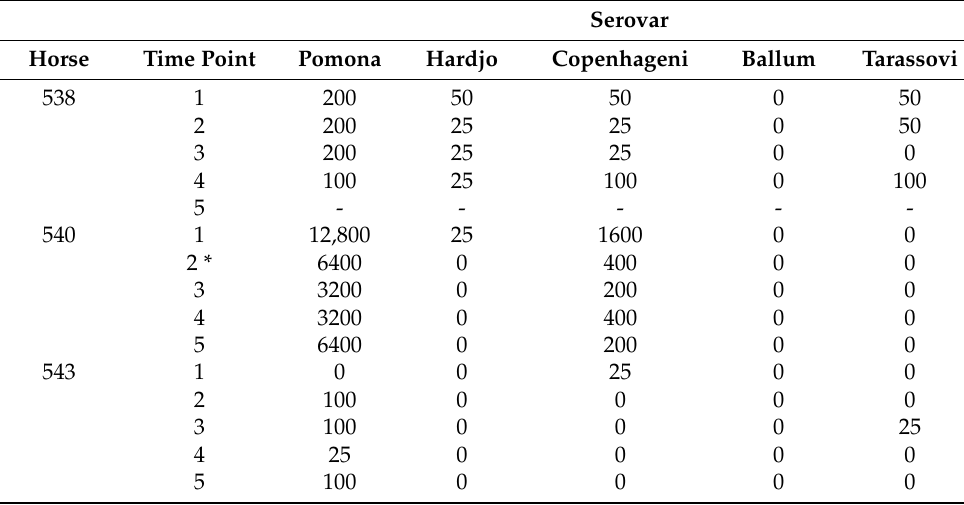
Table 4. MAT titre results by serovar and time point for positive horses, those with at least one MAT titre of ≥ 100 to any serovar at any time point, in a group of horses tested for Leptospira antibodies, which were located near to outbreak of leptospirosis in